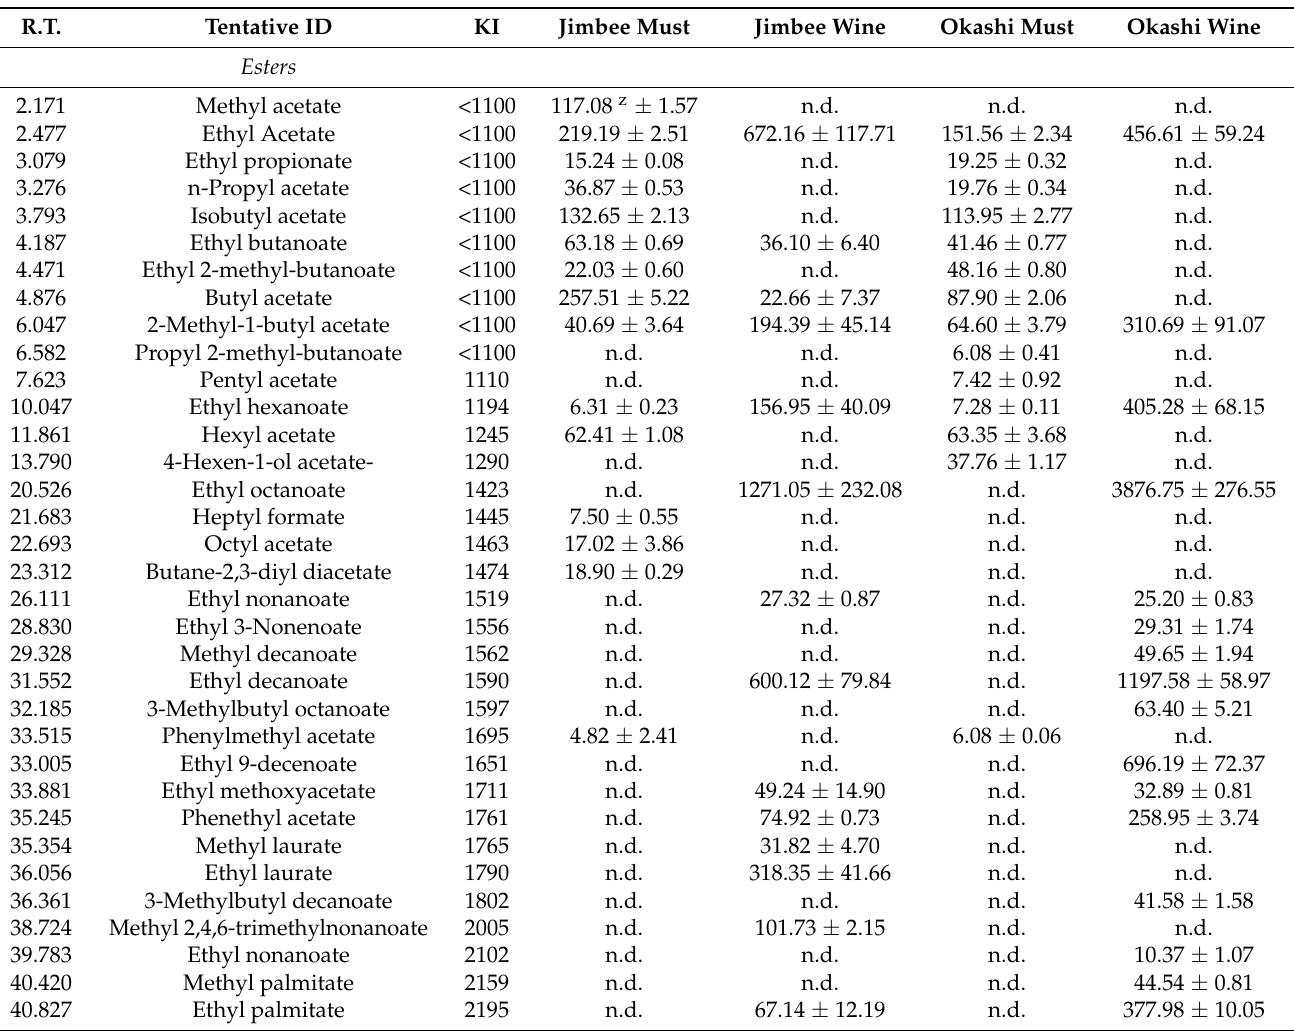
Table 5. Identification and quantification ( µ g/L) of volatile compounds in the Jimbee and Okashi melon musts and